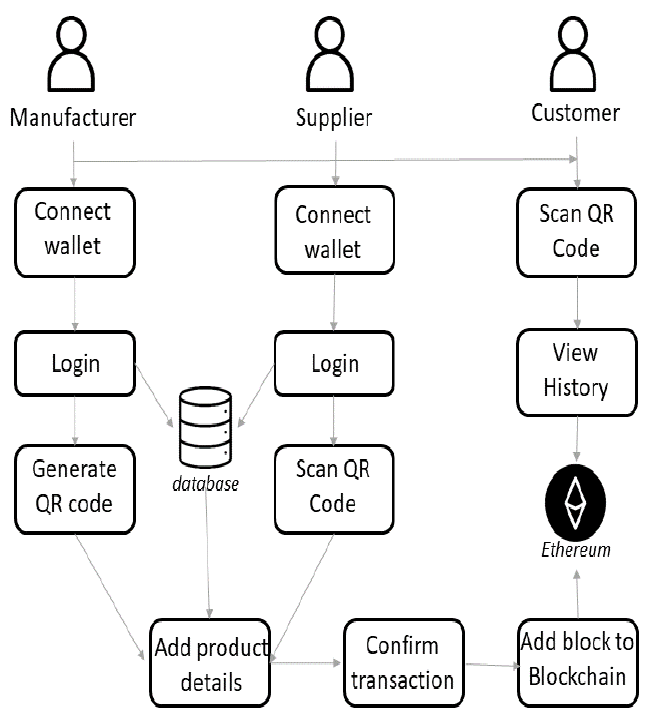
Figure 4: System